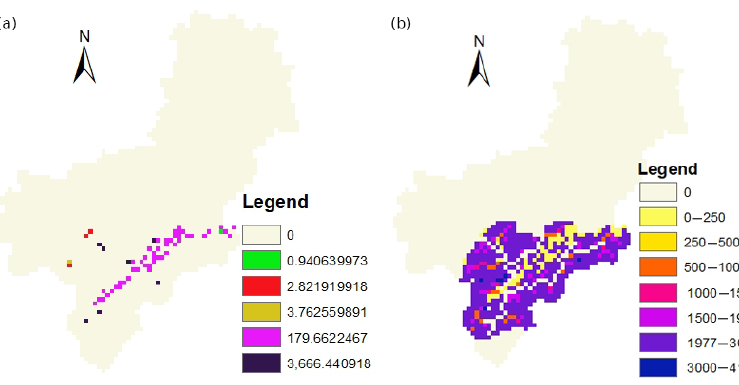
pollutant transport. For slope transport process, NPS, such as natural woodland source, rural NPS and construction land source, are the dominant pollution sources. For river chan- nel grids, the dominant pollution source is PS, i.e. industrial waste-water